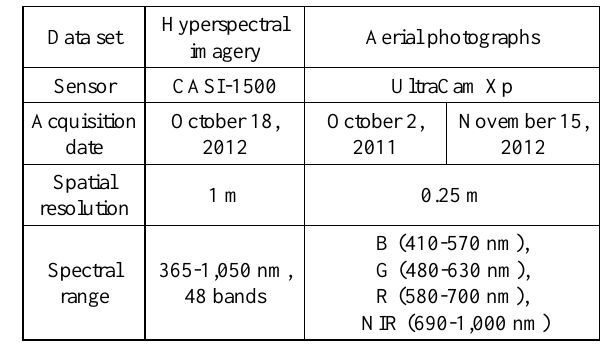
Table 1. Specifications of hyperspectral imagery and aerial